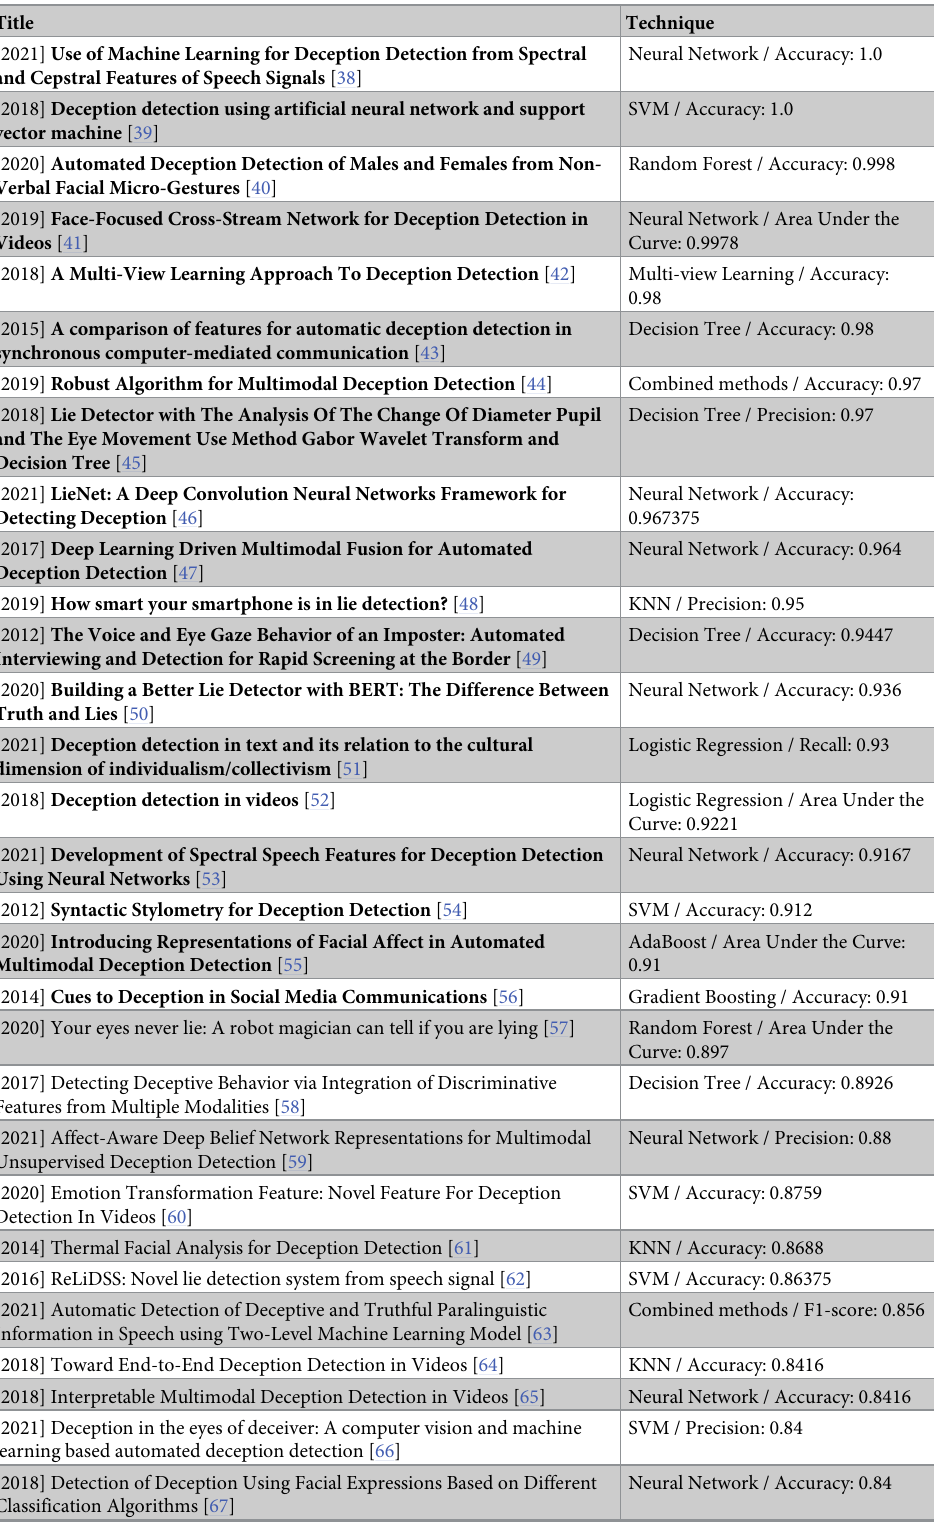
Table 2. List of all 81 selected